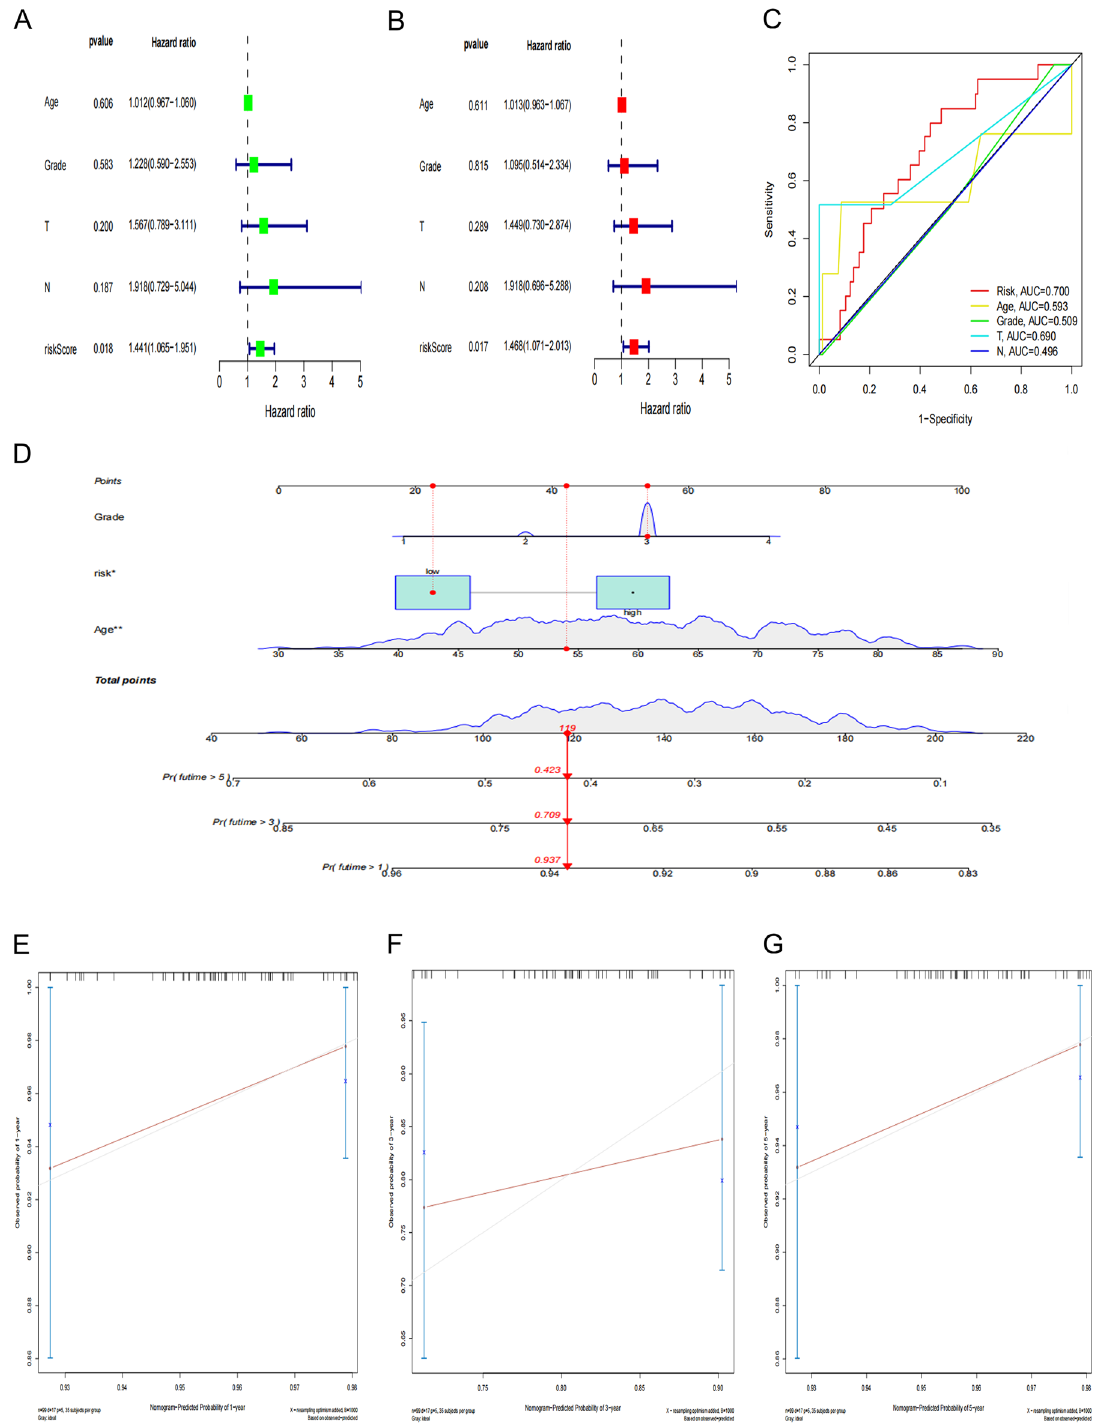
Figure 8. Independent prognostic value of risk score model. ( A – B ) Univariate and multivariate COX regression analysis on OS in the TCGA cohort. ( C ) Clinical ROC curves to forecast overall survival of patients. ( D ) Establishment of nomogram in forecasting OS rates at 1-year, 3-year and 5-year survival probabilities. ( E – G ) Nomogram calibration curves are used to investigate the predictive results and deviations of actual 1-year, 3-year and 5-year survival